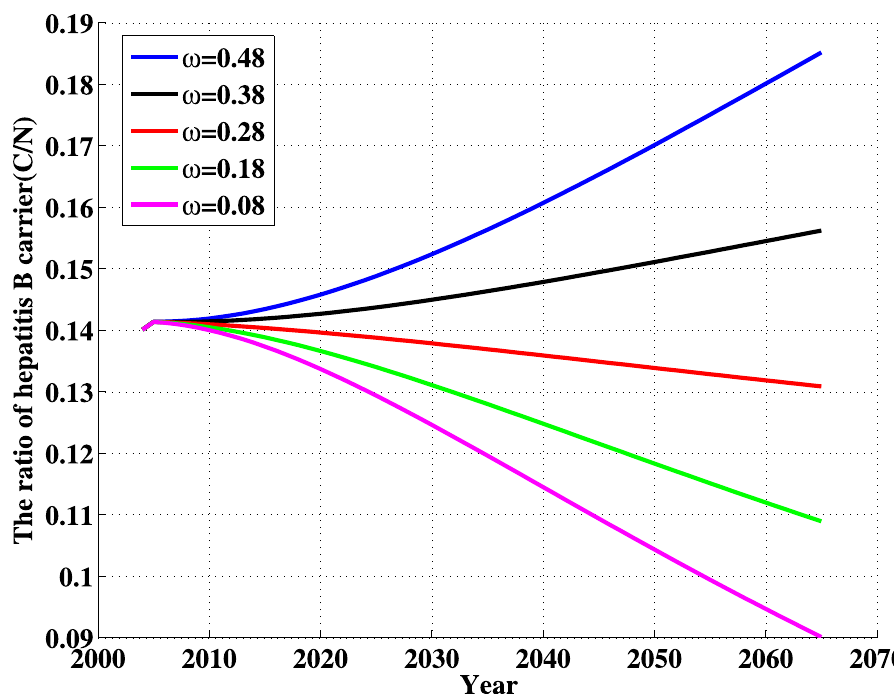
Fig 7. The influence of the parameter ω on the ratio of hepatitis B carrier ( C of ω